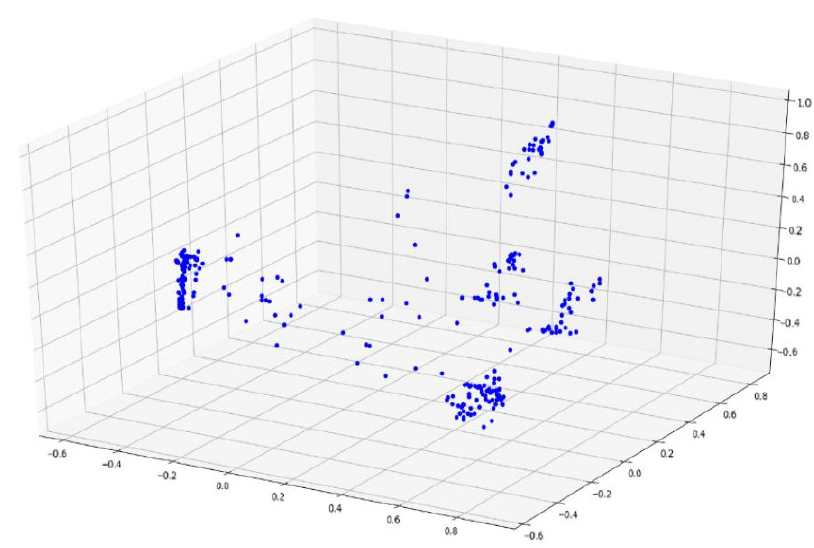
Figure 7. Sample distribution based on the improved Markov chain feature engineering.